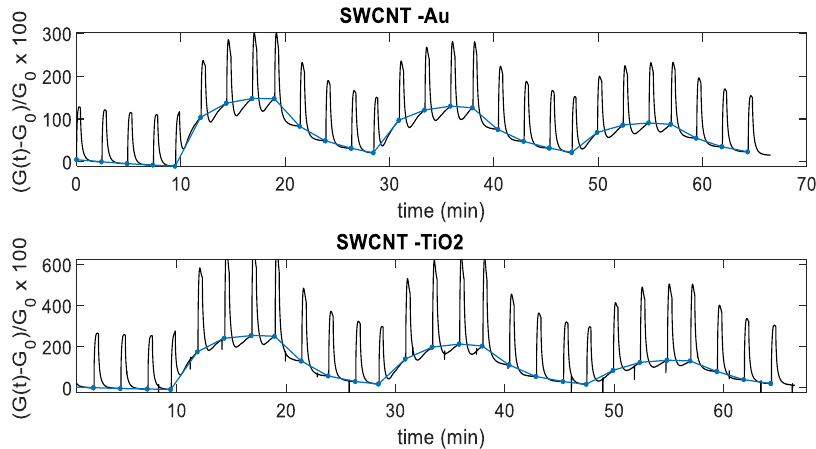
Figure 12. Black-line: Measurement results for the normalized conductance as a function of time for the two materials assuming the measurement profile as in Figures 11 and 12. Blue-line: Responses sampled at the end of the low temperature ( T low ) phase.